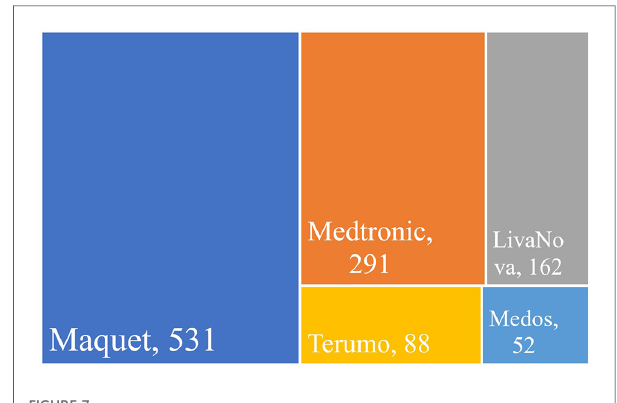
FIGURE 7 Number of research papers using different branded products in the fi eld of ECMO, 2018 –